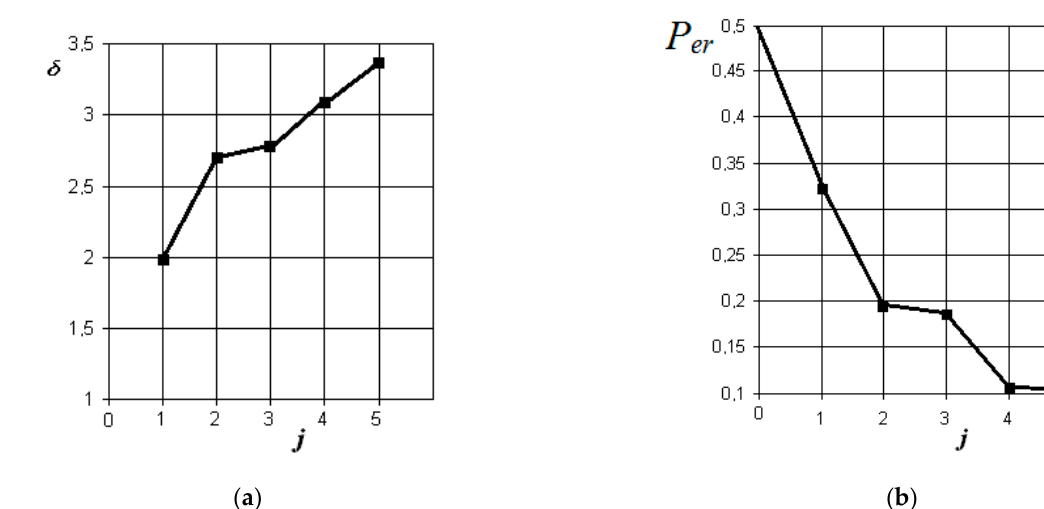
The graphs of the increase in the normalized Euclidean distance and the change in the probability of an error in making a diagnostic decision when monitoring various pathologies with the norm are shown in Figures 6–9, respectively.